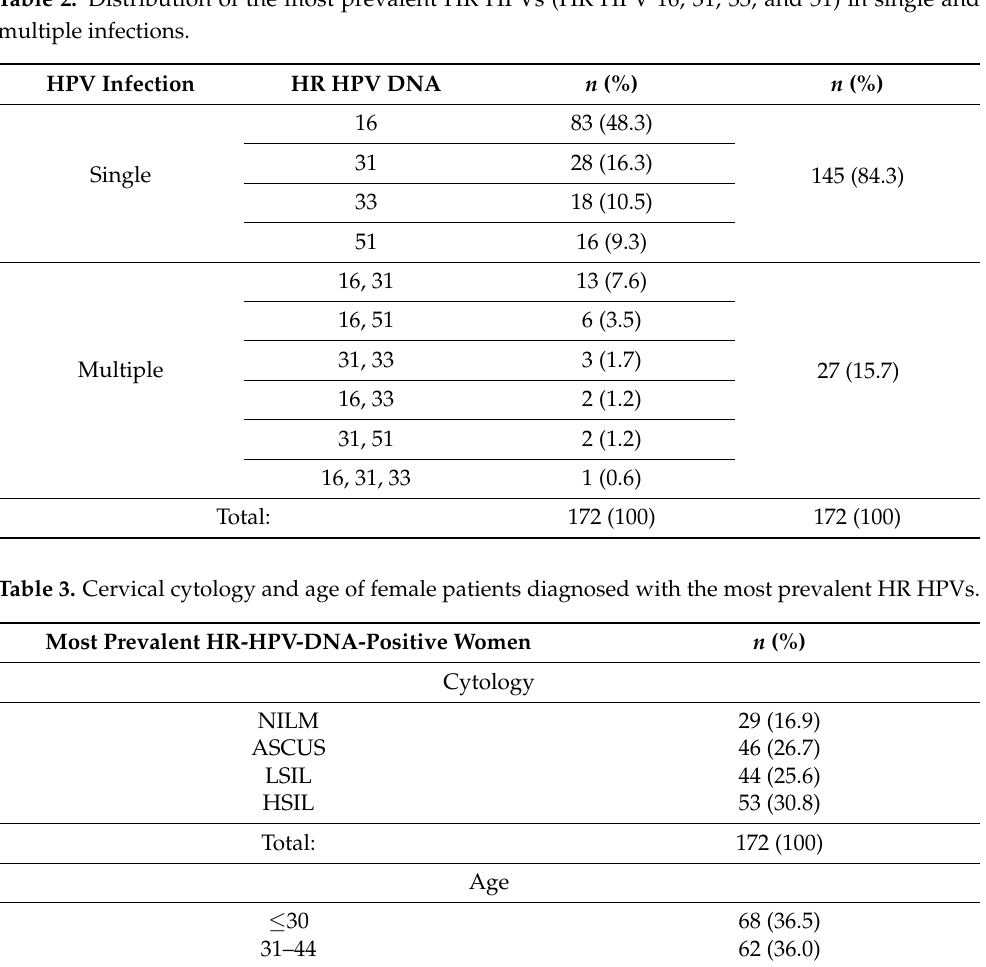
Table 2. Distribution of the most prevalent HR HPVs (HR HPV 16, 31, 33, and 51) in single and multiple infections.